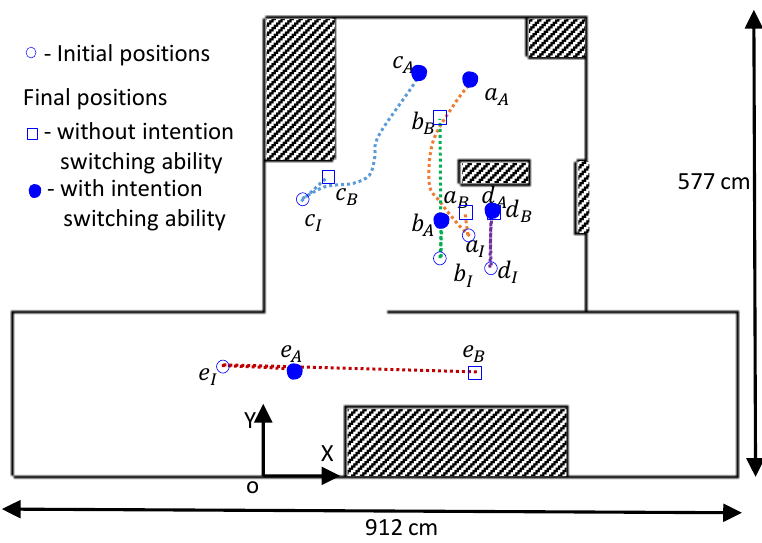
Figure 7. The initial and final positions of the robot during the experiment for identifying the behaviors of the proposed method are marked on the map with corresponding case letters. The shaded areas represent the objects in the environment. The map is drawn to a scale. However, it should be noted that the markers do not represent the actual size of the